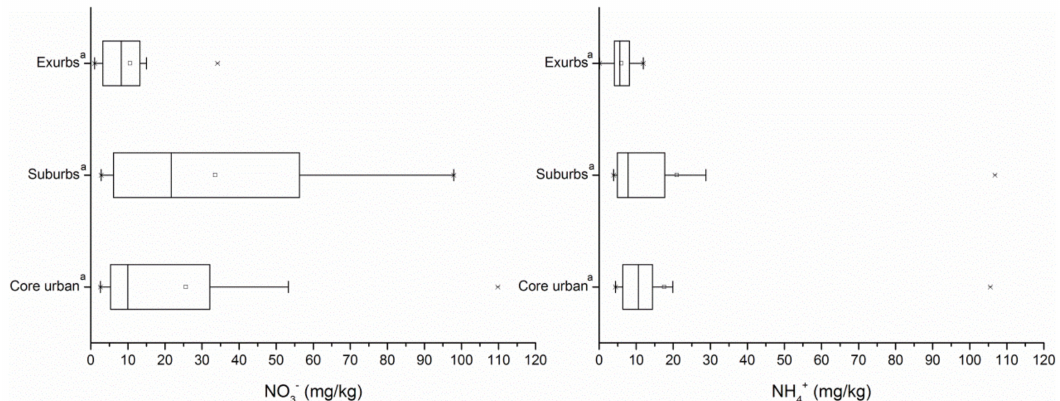
Figure 2. The changing trends of NO 3 − -N and NH 4+ across urbanization gradients. The same letter “a” indicates no significant differences across the urban gradients at a p <